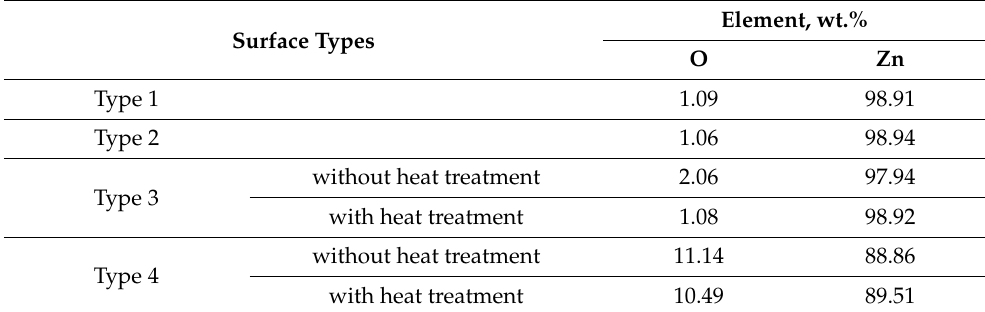
Table 2. The elemental composition of the zinc surface with different texturing methods, determined by EDX